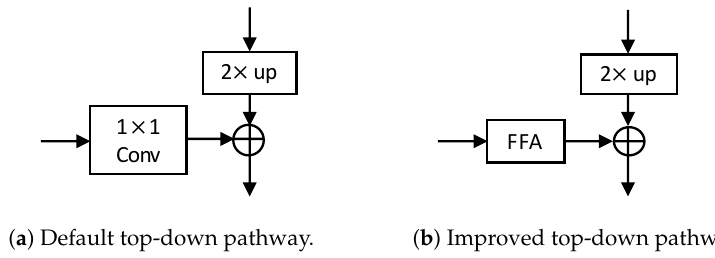
Figure 3. Comparison between the default top-down pathway and the improved method.